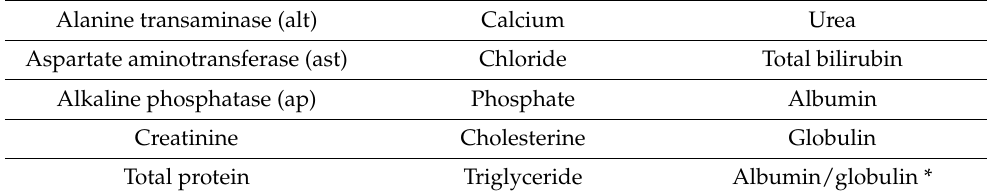
Table 13. Clinical biochemistry parameters. Alanine transaminase (alt) Calcium Urea Aspartate aminotransferase (ast) Chloride Total bilirubin Alkaline phosphatase (ap)